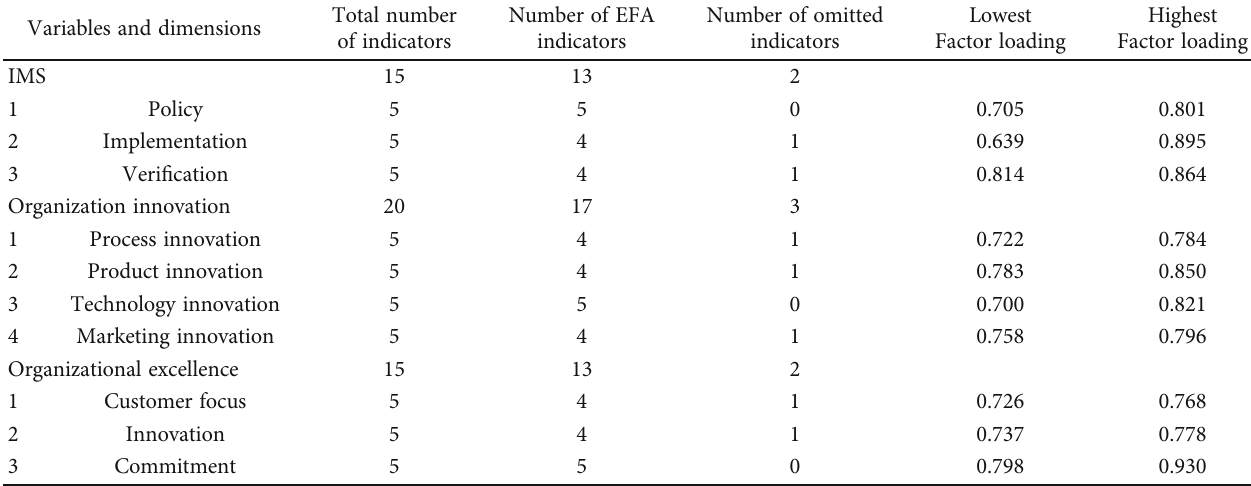
Table 7: Rotated component matrix of variables.